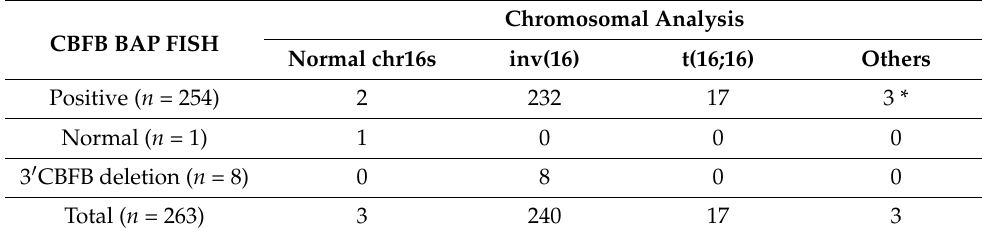
Table 4. Correlation between chromosomal analysis and CBFB BAP FISH results in this study.